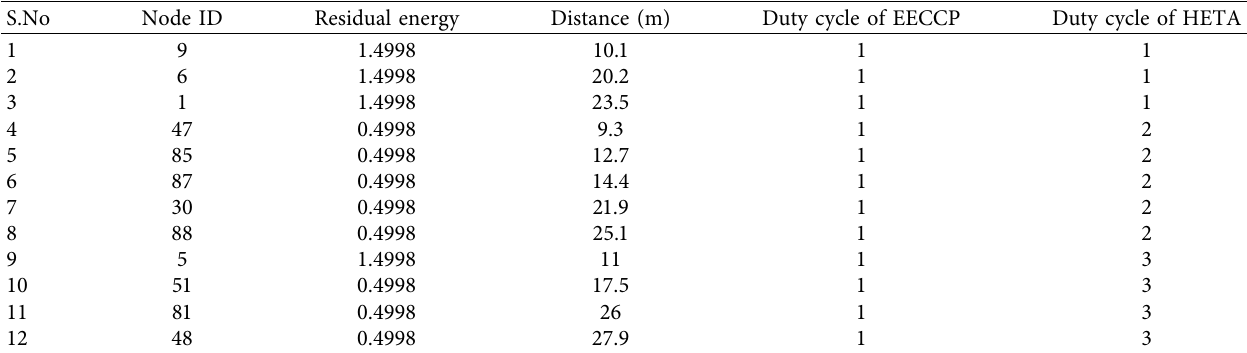
Figure 5: Throughput of the network in different scales. (a) 10% of heterogeneous energy; (b) 20% of heterogeneous energy. Table 3: Traffic near to the base station.